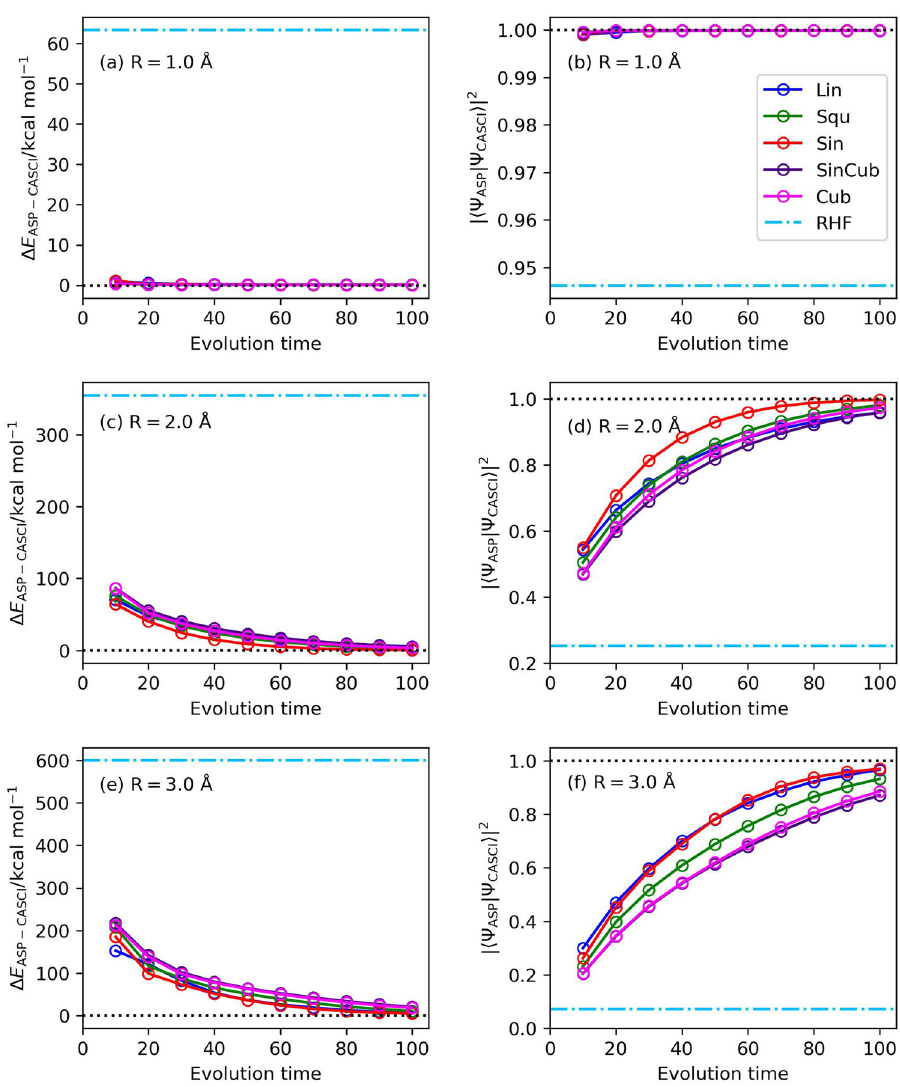
Fig. 2 Results of the numerical quantum circuit simulation of N 2 molecule. a , c , e The energy deviations from the CASCI values in ( a ) R(N – N) = 1.0 Å, ( c ) R(N – N) = 2.0 Å, and ( e ) R(N – N) = 3.0 Å. b , d , f The square overlaps with the CASCI wave function in ( b ) R(N – N) = 1.0 Å, ( d ) R(N – N) = 2.0 Å, and ( f ) R(N – N) = 3.0 Å.